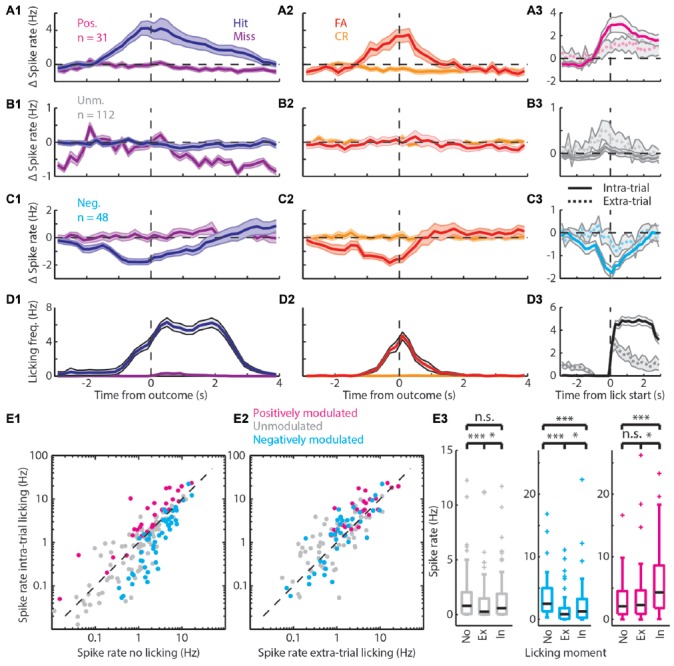
Spiking modulation encodes motivation in addition to motor output. (A) Average PETHs of spiking of the positively modulated population (n = 31). (A1) Spiking aligned to “Go” trial outcome. (A2) As in (A1) but for “No-go” trials. (A3) Spiking aligned to lick start for intra-trial licking bouts (solid line) and extra-trial licking bouts (dashed line). (B) (B1–B3) analogous to (A1–A3) but with PETHs of the unmodulated population (n = 112). (C) (C1–C3) analogous to (A1–A3) but with PETHs of the negatively modulated population (n = 48). (D) (D1–D3) analogous to (A1–A3) but with licking PETHs. See Supplementary Figure S1 for a separation of units that are (un)correlated to licking frequency. (E1) Scatterplot of spike rate outside licking bouts vs. spike rate during intra-trial licking bouts. Note the shift from the unity line for the positively (magenta) and negatively (cyan) modulated units. (E2) Scatterplot of spike rate during extra-trial licking bouts vs. intra-trial licking bouts. Note the shift of both the positively and negatively modulated populations above the unity line. (E3) Boxplots of spike rates outside of licking bouts (No), during extra-trial licking bouts (Ex) and during intra-trial licking bouts (In) for the three functional populations. n.s. not significant (p > 0.05), *p < 0.05, ***p < 0.001.